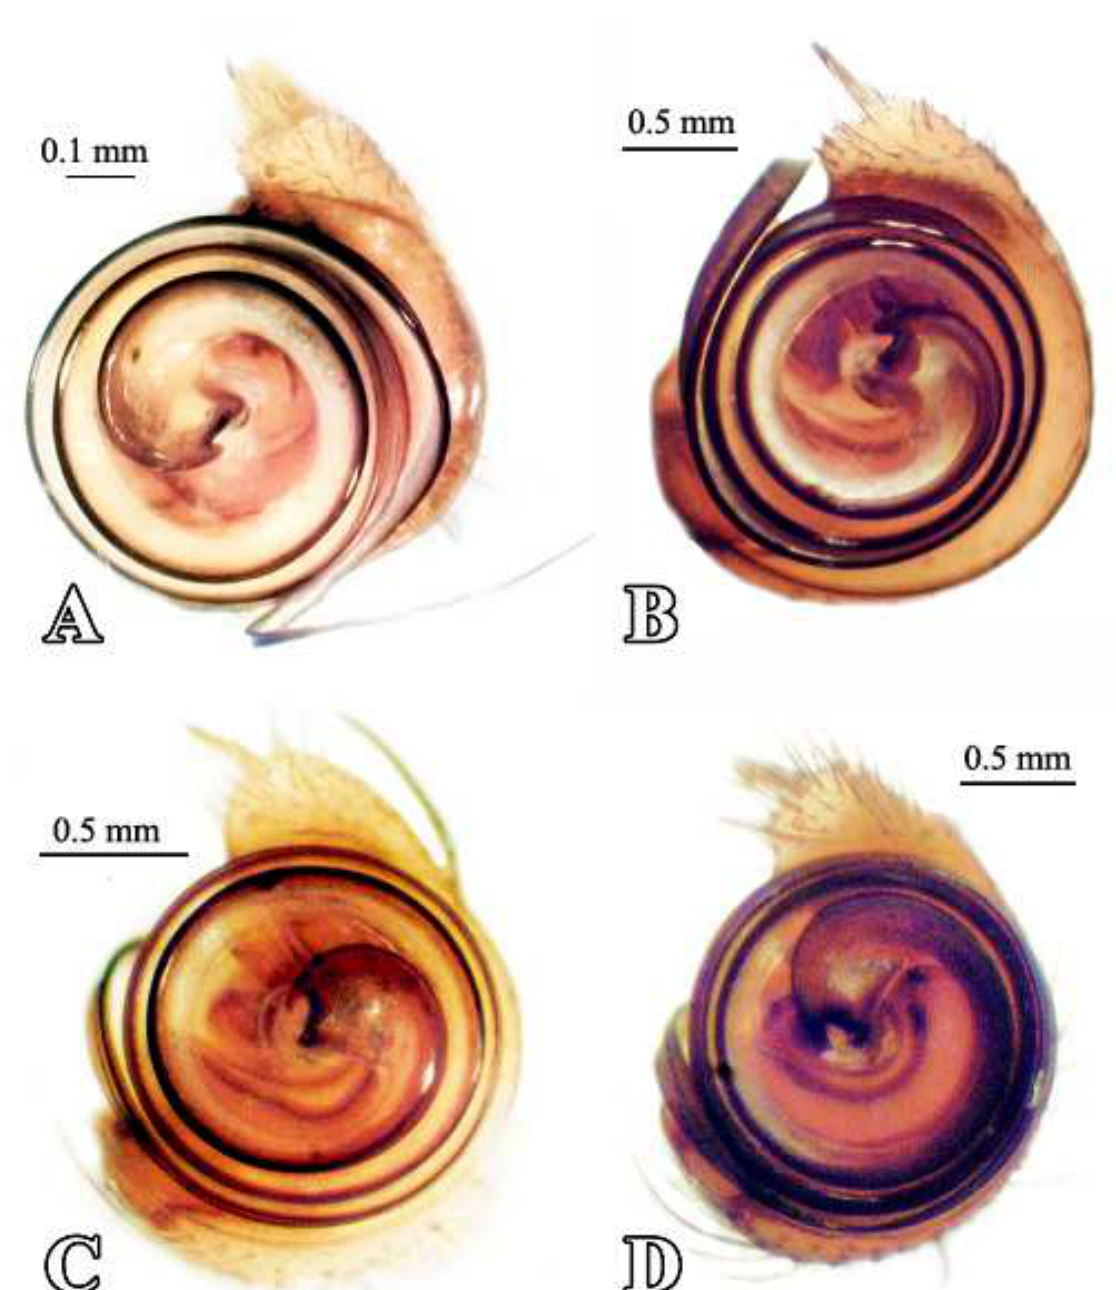
F IGURE 2 . Tarsi of male pedipalps of Latrodectus spp (ventral view). A) L. dahli ; B) L. tredecimguttatus ; C) L. pallidus ; D) L. cinctus. Diagnosis: Size between 3-6 mm in males, and 9-17 mm in females; coloration of female opisthosoma usually black with several red spots, thought the Iranian populations mostly uniformly black (Fig. 4C); emboli of male palps with three loops (Fig. 2B); spermathecal ducts of female vulva with four loops (Fig. 3B). Habitat: Steppe habitats of semi-desert areas. Global Distribution: Mediterranean to China (Platnick,